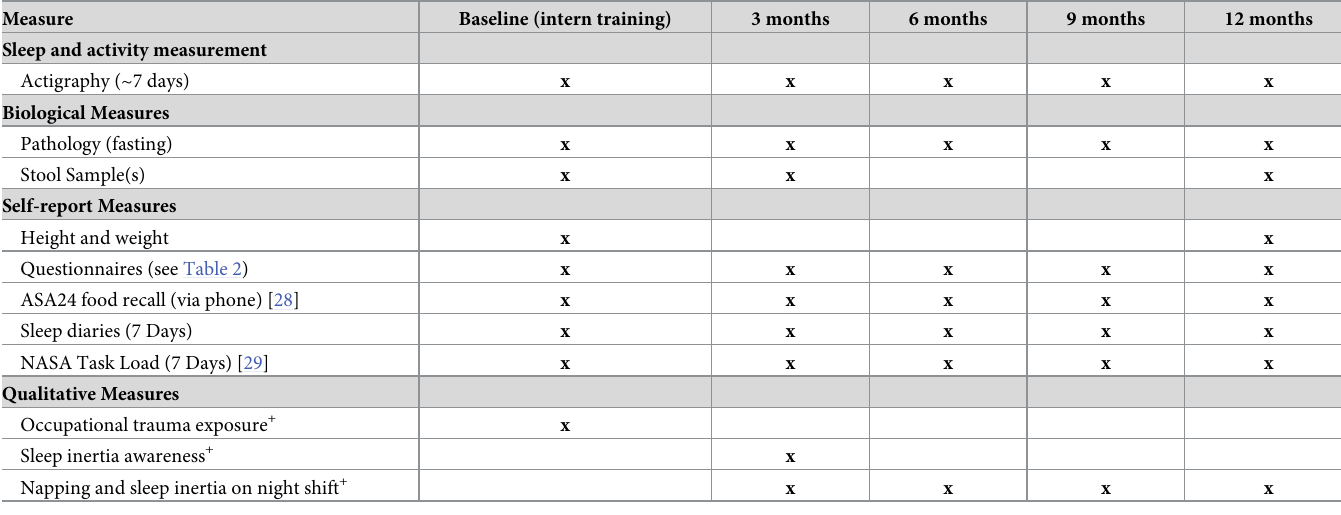
Table 1. Time points for measures collected in the